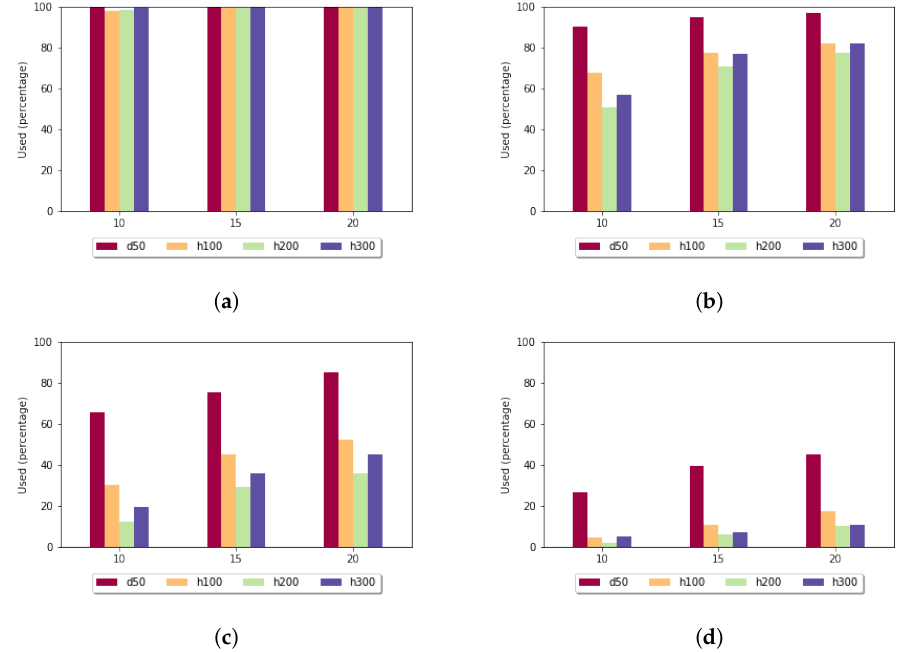
Figure 7. Utilization rate (y axis) depending on the size of the sample set (x axis) and length of the k-mers in the case of fixed gap penalty: ( a ) k = 5; ( b ) k = 7; ( c ) k = 10; and ( d ) k =